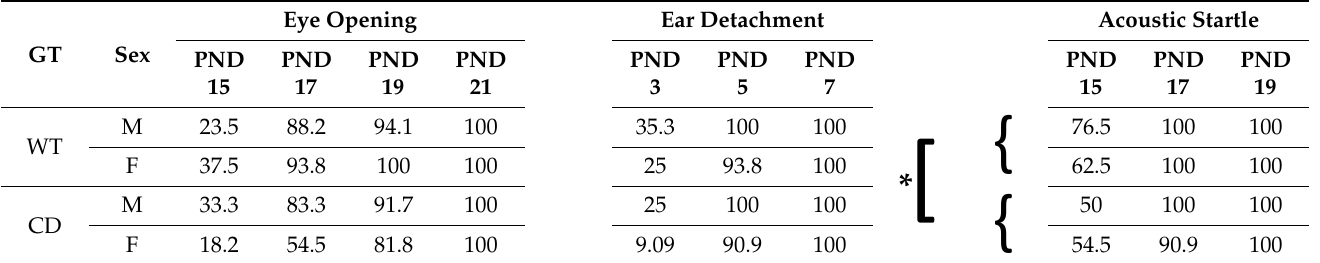
Table 1. Developmental milestones. Number indicates the cumulative percentage of animals of each experimental group reaching the developmental milestones on the corresponding days. * p < 0.05: on PND 15, WT versus CD mice (males and mutants pooled together).